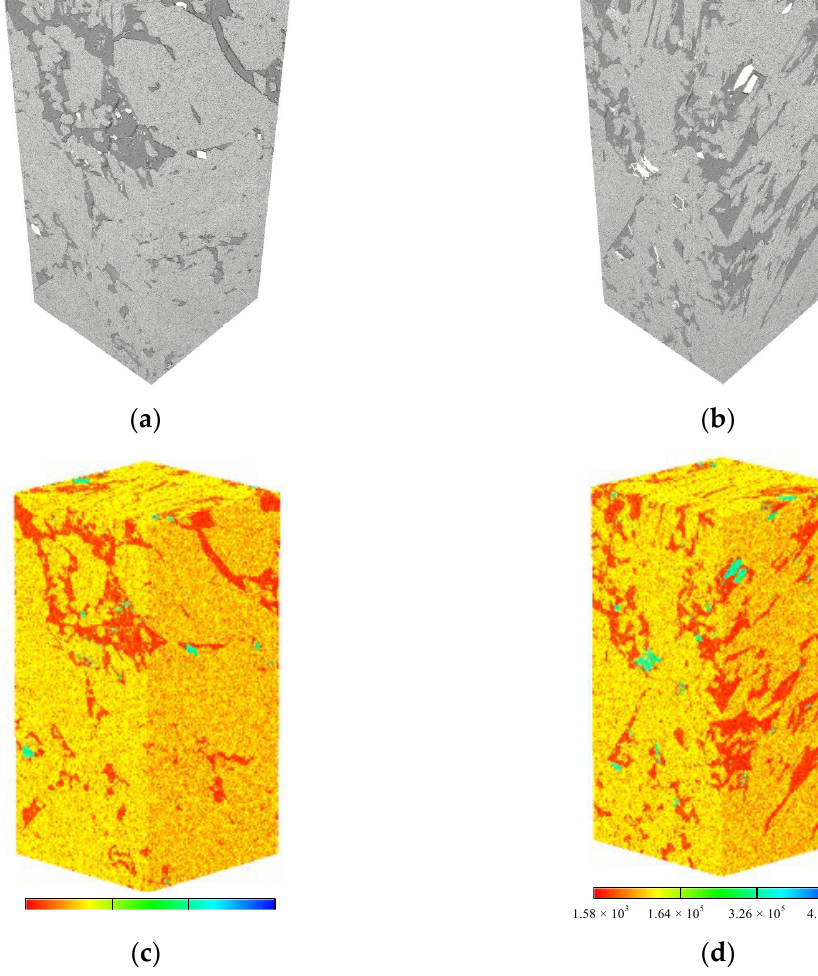
Figure 5. Shale microscopic model. ( a , b ) Original FIB-SEM 3D model: ( a ) is a front view, and ( b ) is a back view. ( c , d ) Finite element numerical model, expressed by elastic modulus: ( c ) is a front view, and ( d ) is a back view. ( organic matter, carbonate minerals, pyrites).